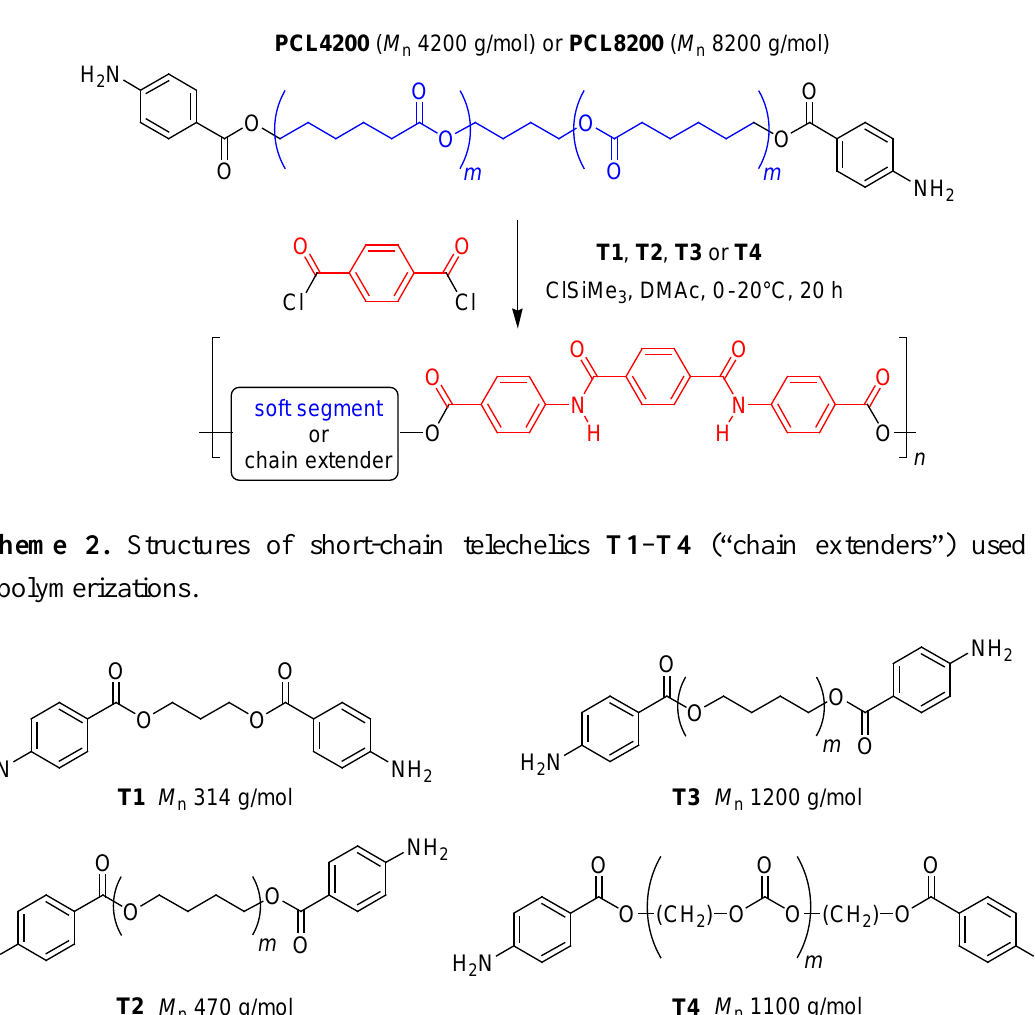
Scheme 1. Structure of PCL4200 / PCL8200 and typical polymerization procedure (soft segments are highlighted in blue, hard segments in red).